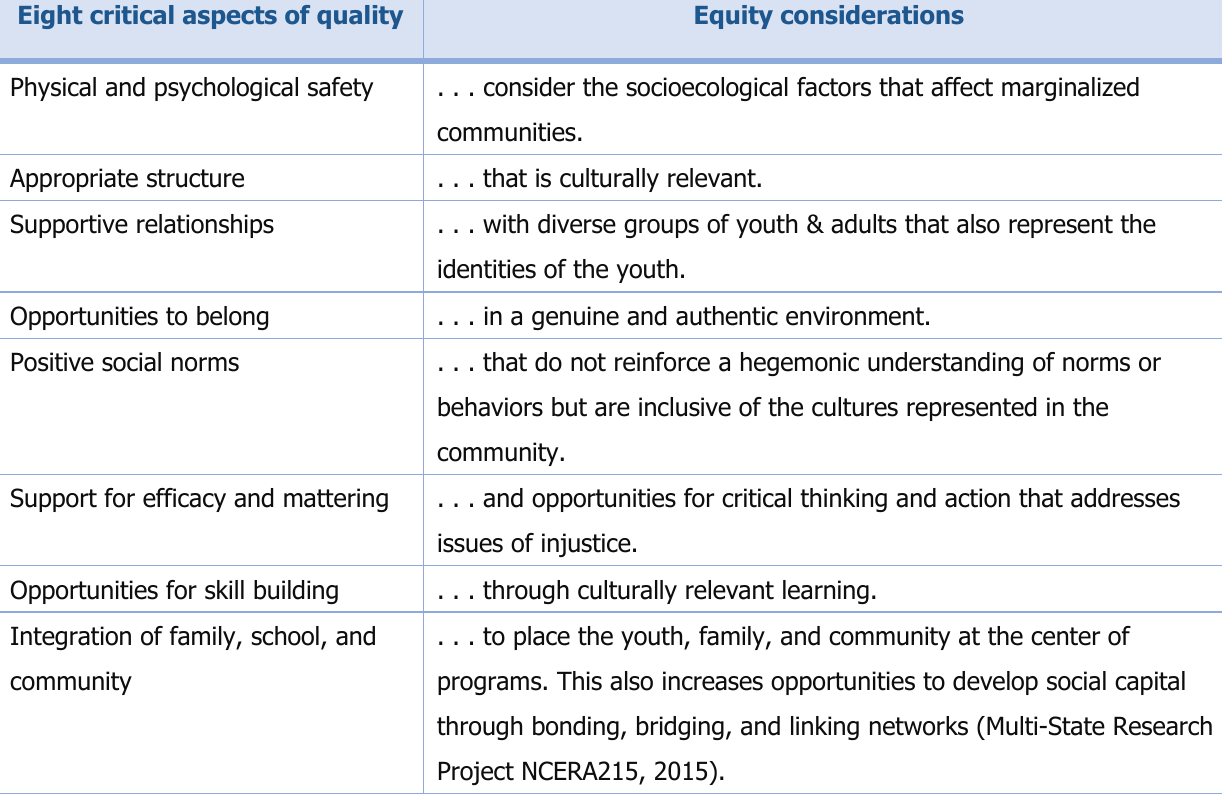
Table 2. Equity Considerations for 4-H Thriving Quality Aspects Eight critical aspects of